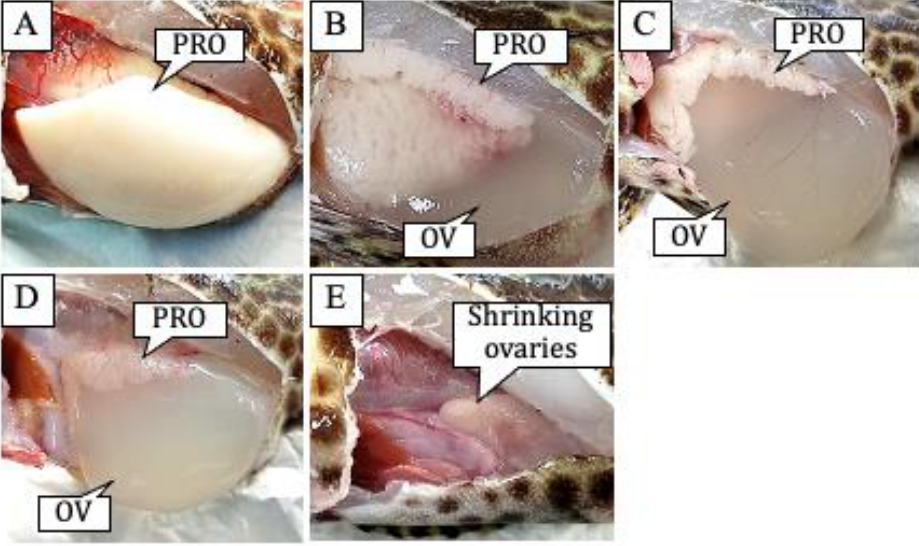
Figure 4. Morphological changes in the Epinephelus merra ovaries collected from the spawning aggregation site in May and June 2018. ( A ) An ovary of a pre-ovulatory female captured on 31 May. ( B ) An ovary of an ovulatory female captured on 1 June. ( C ) An ovary of an ovulatory female